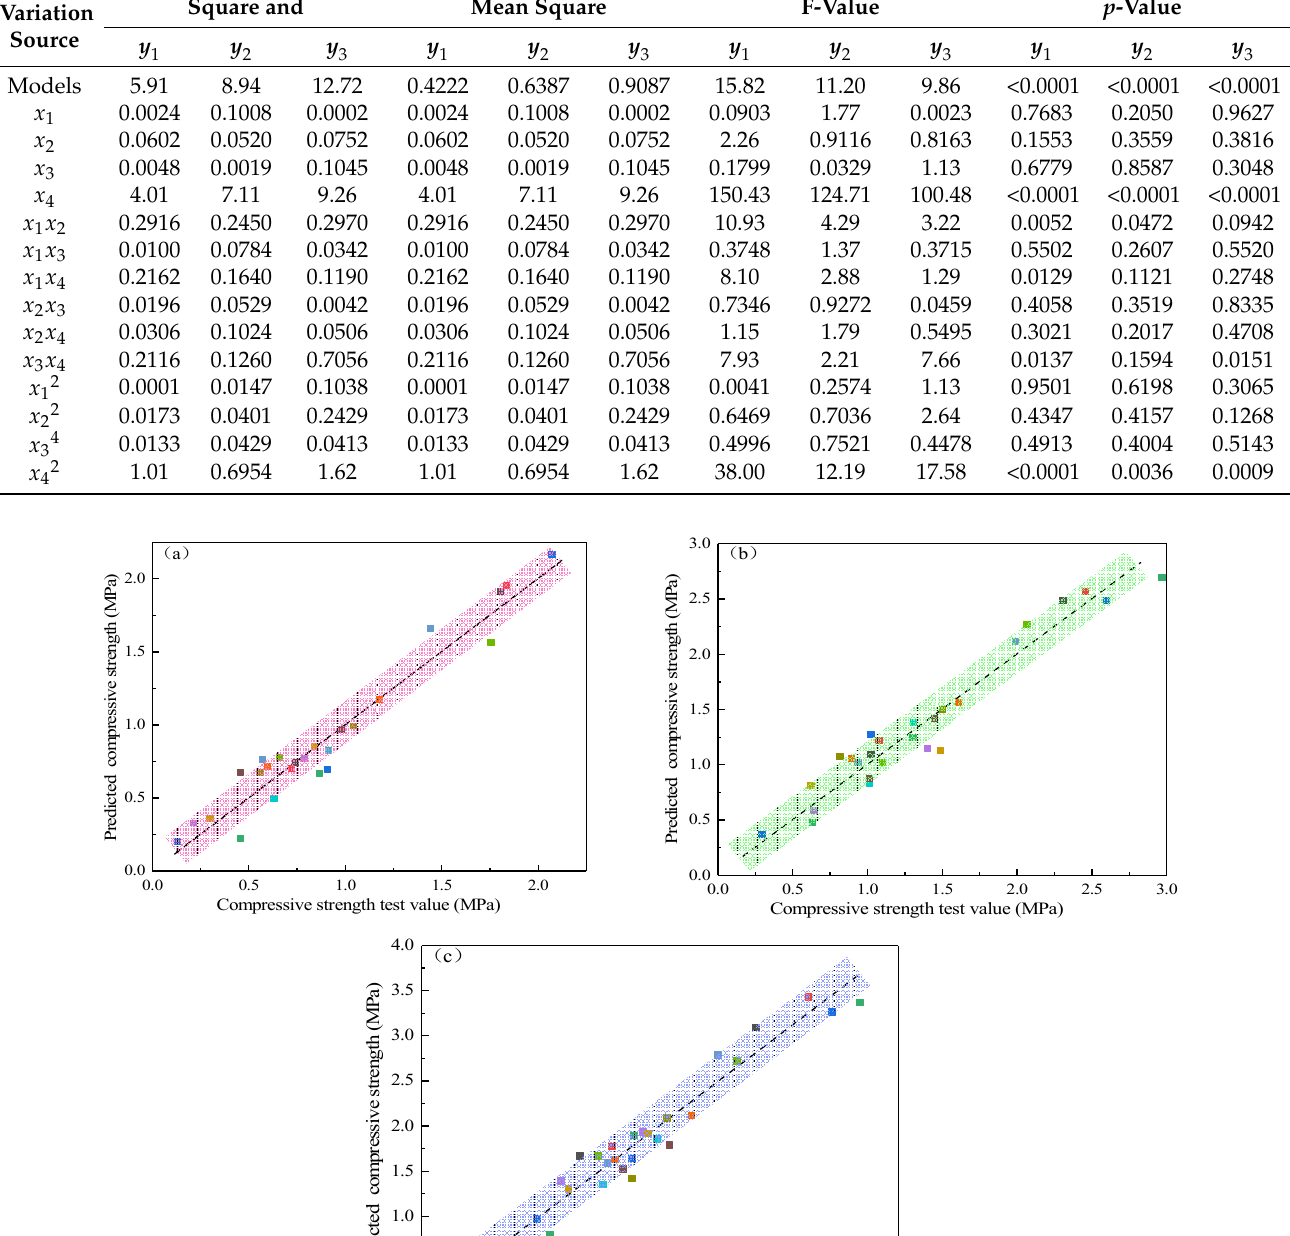
Table 4. Response surface regression model analysis of variance.